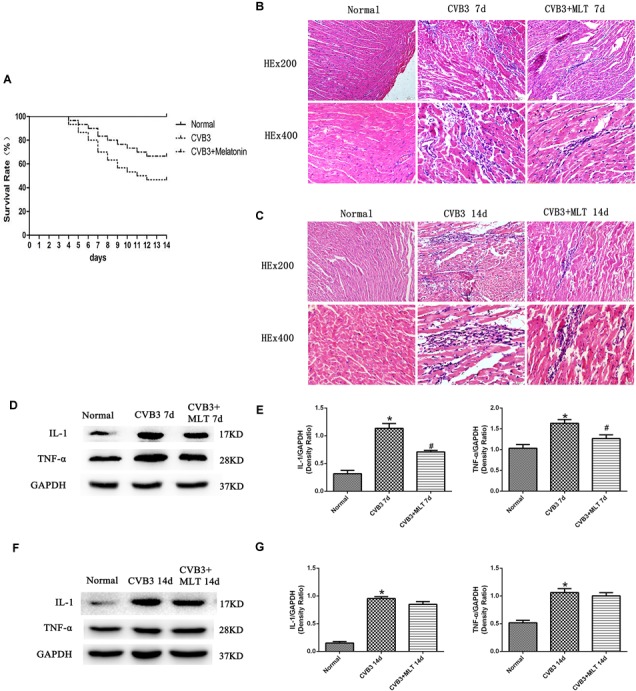
The survival rates of three groups of mice followed for 14 days, with HE staining of the myocardial tissue to evaluate the histological changes on days 7 and 14 (n = 5 in each group, three sections per heart were examined), and the expression of proinflammatory cytokines in the myocardium (n = 5 in each group). (A) Compared to the CVB3 group, the survival rate of the CVB3 + MLT group was increased. (B,C) Histological analysis of the infected hearts on days 7 and 14 (original magnification × 200, × 400). (D,F) Representative levels of proinflammatory cytokines on days 7 and 14. (E,G) Density ratio of the proinflammatory cytokines to Gapdh. ∗P < 0.05 versus the normal group, #P < 0.05 versus the CVB3 group.